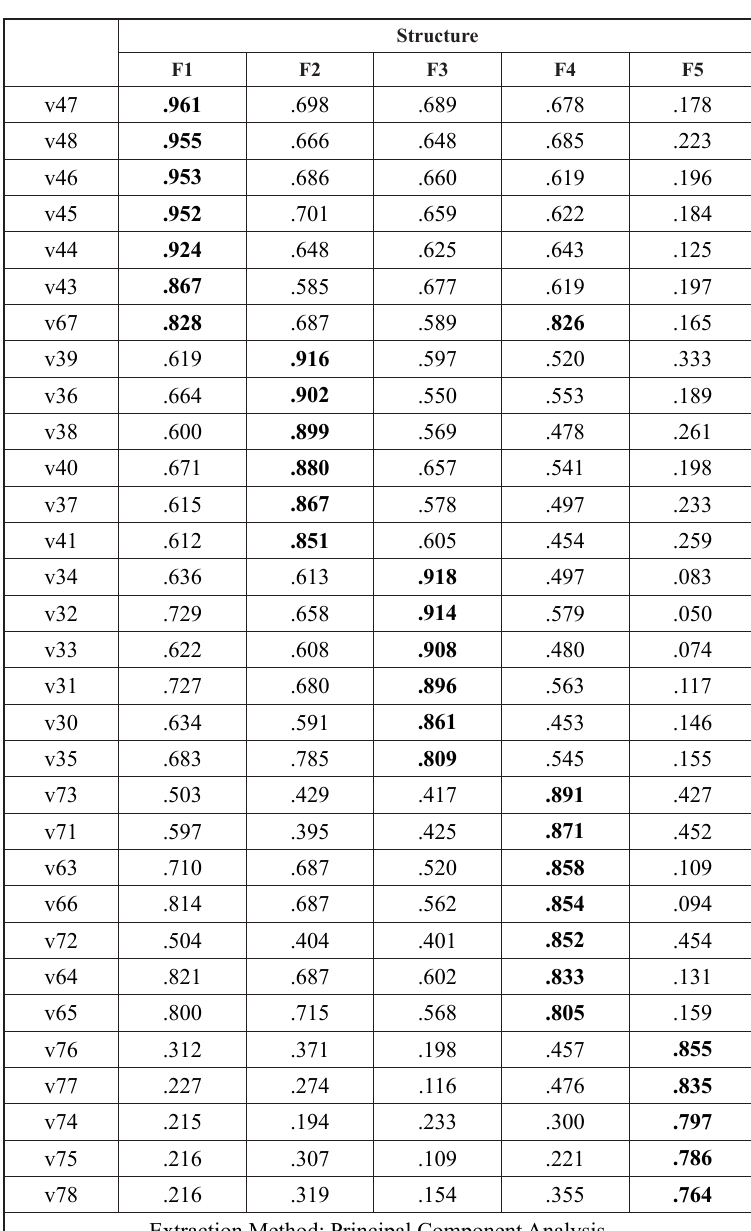
Table 6. Factor structure (F) of students’ en - trepreneurial